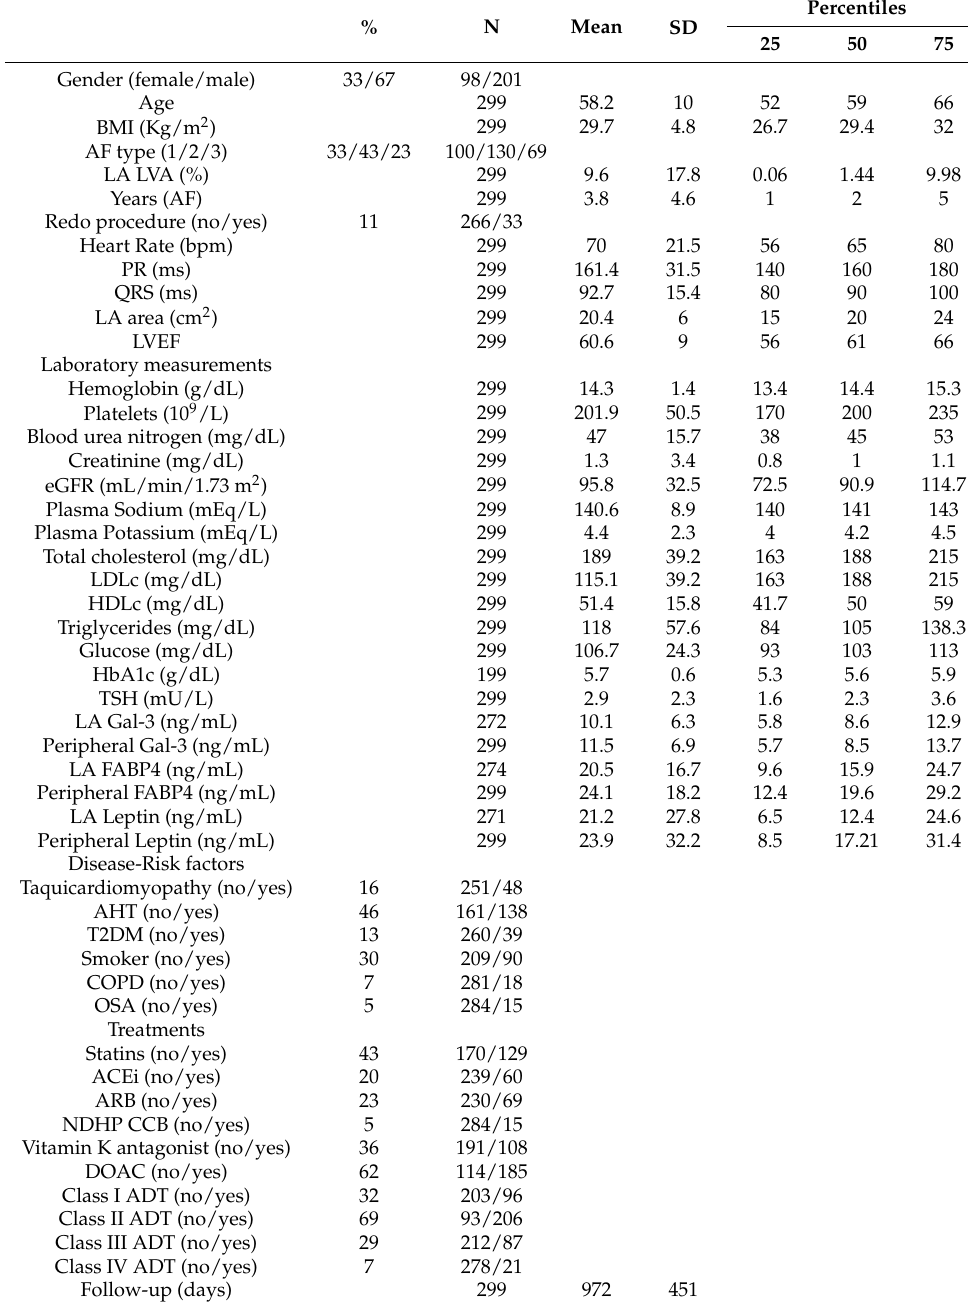
Table 1. Characteristics of the patients at